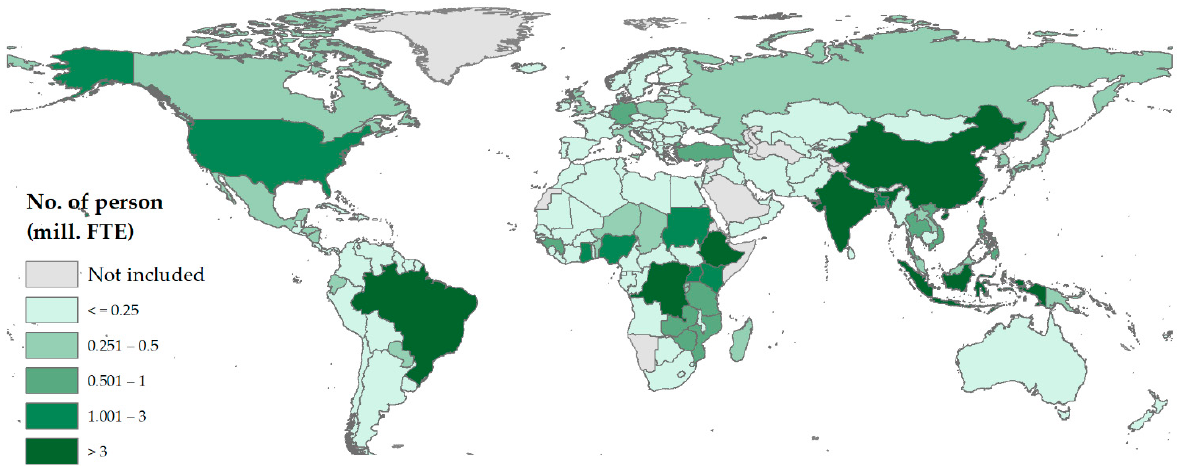
Figure 5. Global view of total forest-based employment. Source: own illustration. Notes: Global employment in this map encompasses visible employment in the forest sector and the lower-bound invisible employment estimates in the forestry and logging sub-sector; NWFP not included. Table 4. Number of visible and invisible employment from selected countries.